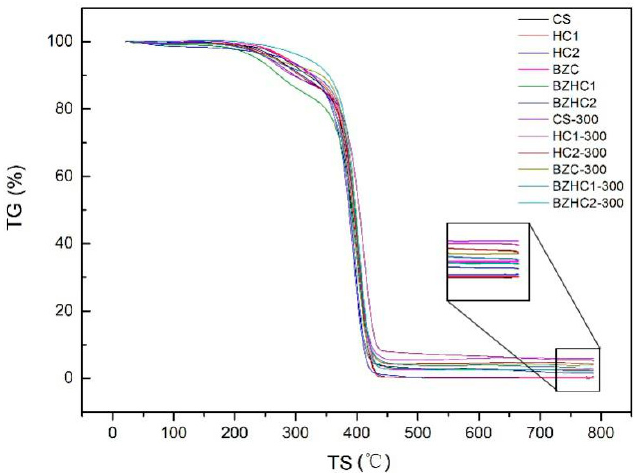
Table 4. Pyrolysis residual content of unweathered and weathered samples.